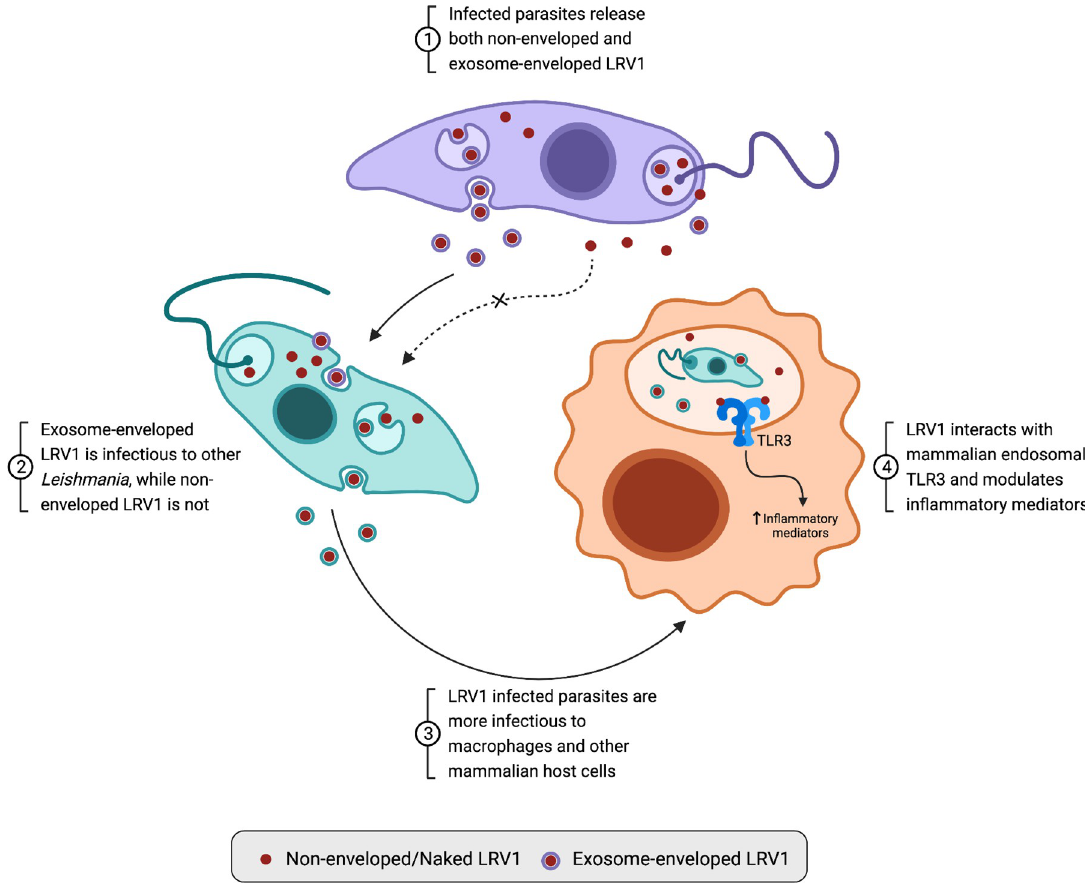
Fig 1. Leishmanial exosomal pathway hijacking by LRV1 enables viral transmission and induces TLR3-mediated hyperpathogenesis in mammalian hosts. LRV1, Leishmania RNA virus 1; TLR3, Toll-like receptor